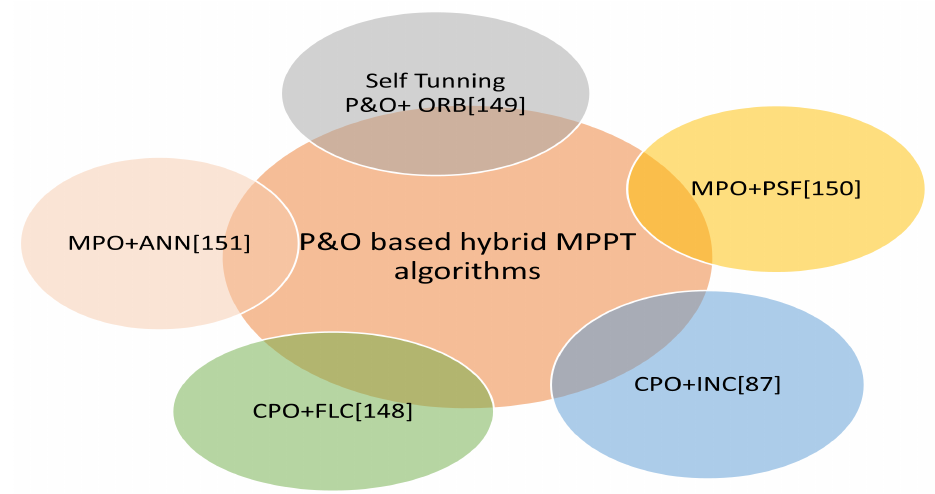
Figure 19. P&O based hybrid MPPT